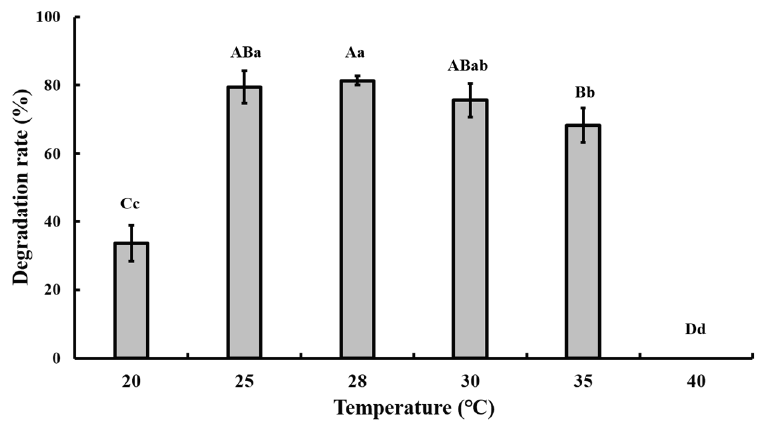
Figure 3. Effect of different temperatures on the degradation of 50 mg/L CAP by strain GW13. The degrading amount of CAP was measured after incubation in pH 7 and 1 g/L glucose adjunction for 24 h. The data are represented as the mean ± standard deviation (SD) for triplicate incubations. Different letters above the bars indicate significant differences among different treatments at p < 0.05 (uppercase) or p < 0.01 (lowercase) (one-way analysis of variance, ANOVA, and Dunnett’s test).